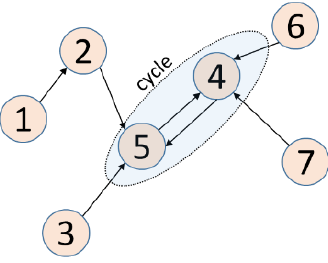
Figure 5. Possible NNG of the RAG in Figure 3 and a cycle in the NNG.